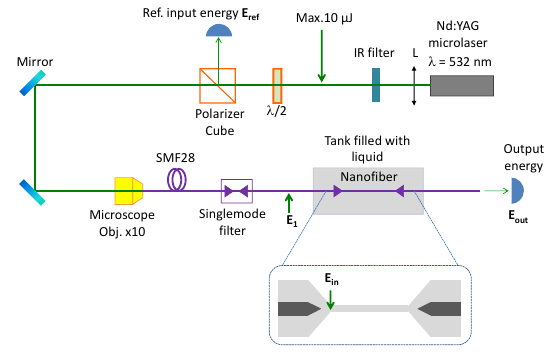
Fig. 1. Experimental setup .